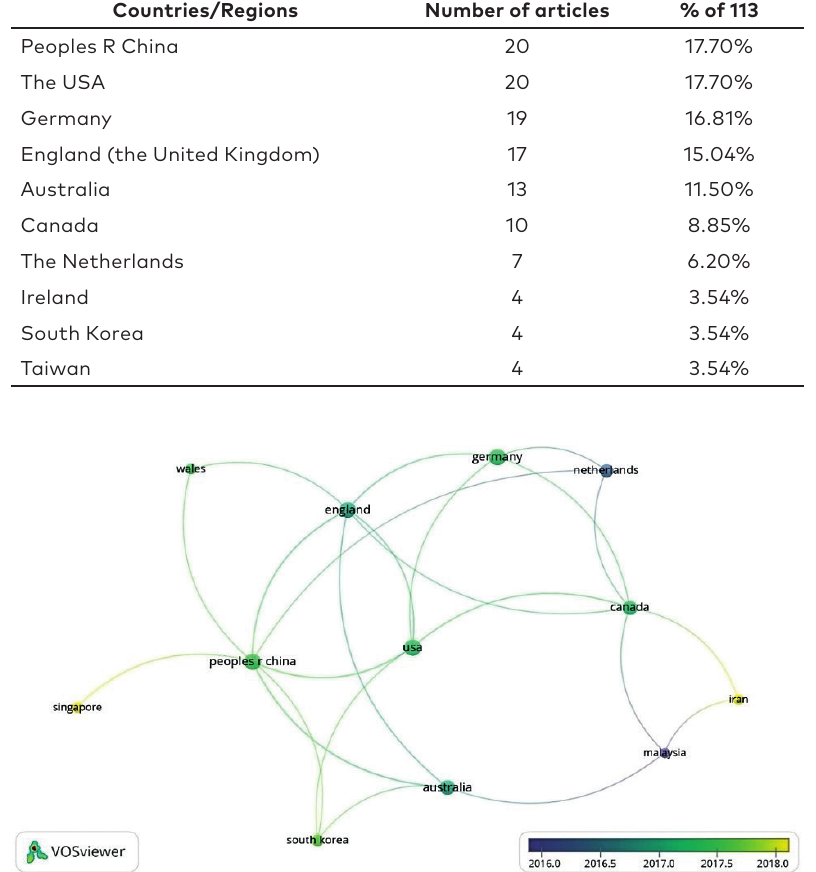
Figure 3. Co-authorship network of